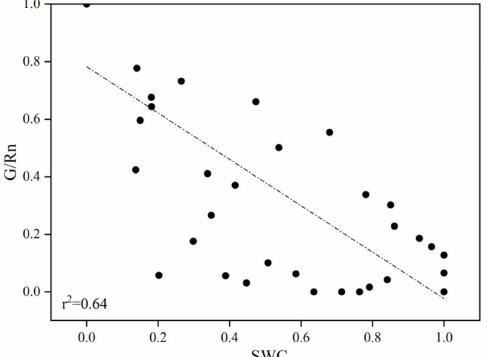
Figure 7. Relationships between normalized soil water content ( SWC ) and the normalized ratio of midday G / Rn in summer. Linear fitted regression of SWC and G / Rn ( r 2 = 0.64, p < 0.05, n = 42).